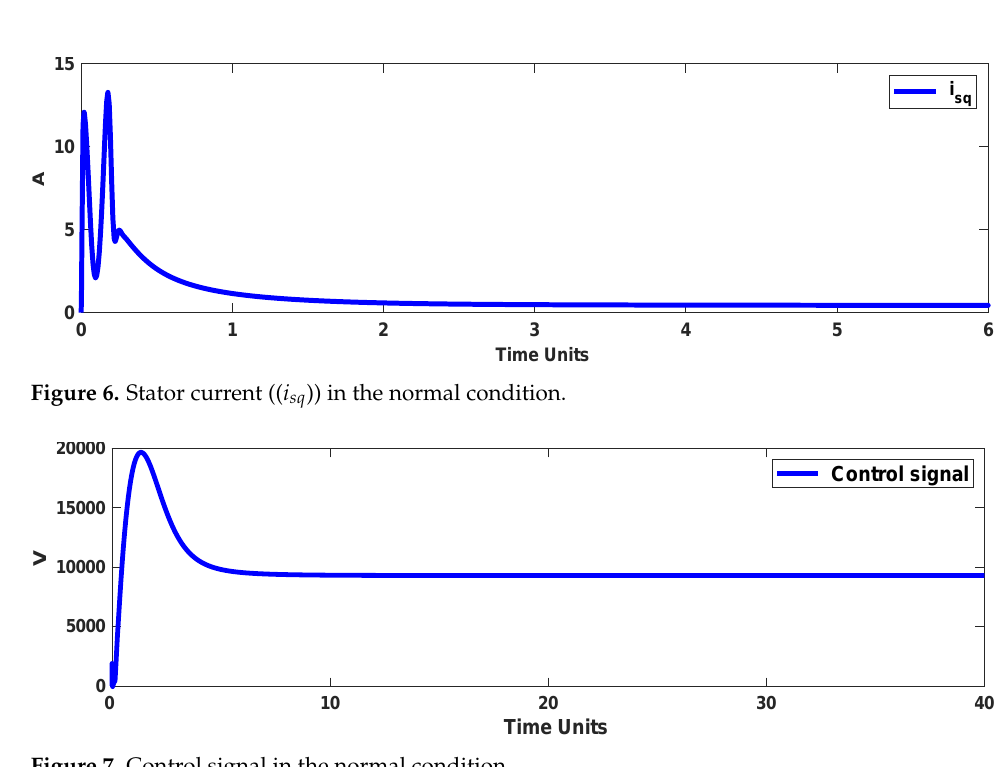
Figure 7. Control signal in the normal condition.